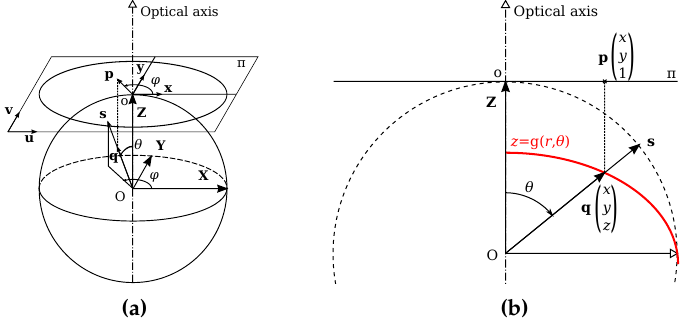
Figure 5. Model of omnidirectional fisheye projection with unique projection centre and symmetry around the optical axis. Π is the image sensor. ( a ) Unit sphere model; ( b ) Cross-section with the curve of a fisheye